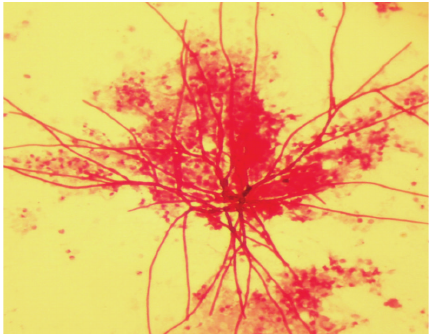
Figure 16: Scleritis due to Histoplasma capsulatum in a female im- munosuppressed patient.